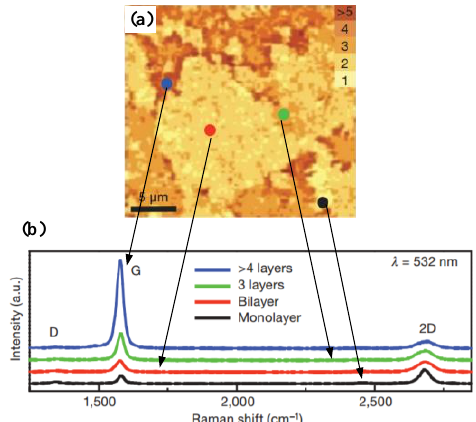
Figure 8. Optical image ( a ) and Raman spectrum ( b ) of graphene films growth on the 300 nm-thick-nickel layer on the Si wafer. (Reproduced from [33] with permission; Copyright 2009 Nature.)